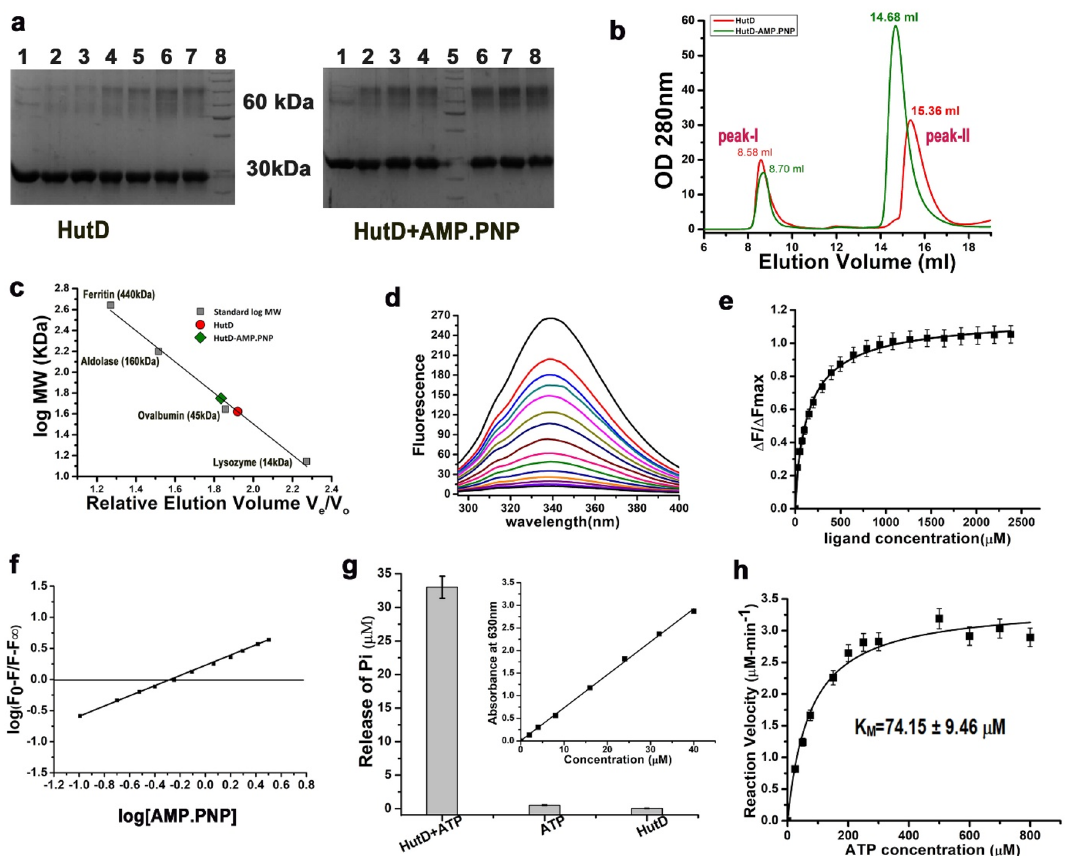
Figure 2. Dimerization and ATP binding/hydrolysis by HutD. ( a ) Crosslinking of HutD with Glutaraldehyde in Nt-free state (left) and after incubation with AMP.PNP showed prevalent dimerization upon incubation with AMP.PNP; left: (L1: Control, L2–L7: after treatment with 0.005–0.04% of Glutaraldehyde, L8: MWM), right: (L1: Control, L2–L4: after treatment with 0.005%, 0.01%, and 0.02% of Glutaraldehyde, L5: MWM, L6–L8: after treatment with 0.03%, 0.035%, and 0.04% of Glutaraldehyde). A cropped version is used here to reduce space and to maintain clarity. Original gel pictures are available in Fig. S1; ( b ) size exclusion chromatography elution profiles of HutD in Nt-free and upon incubation with AMP.PNP; ( c ) the molecular weights of the peaks were determined from the calibration curve prepared using molecular weight standards. Elution volumes suggest strong dimeric shift upon AMP.PNP binding to HutD. ( d,e ) Fluorescence quenching demonstrated significant change in fluorescence upon AMP.PNP binding to HutD; (λ exc = 280 nm, λ em = 295–400 nm) with slit widths of 5 nm for both excitation and emission. Plots of ΔF/ ΔF max against ligand AMP.PNP (mM) obtained a K d value of 94 ± 0.024 μM; ( f ) slope of the straight line indicates 1:1 binding stoichiometry between HutD and AMP.PNP; ( g ) significant ATP hydrolysis of HutD were observed in Malachite green assay and the release of inorganic phosphate ( Pi ) was estimated against the standard curve of KH 2 PO 4 ( Inset ); ( h ) reaction velocity of HutD, measured at a protein concentration of 2.5 μM, were plotted against ATP concentrations (μM) as per Michaelis– Menten equation y = Vmax × x n /(k n + x n ) with ‘One site-specific binding’ model. Error bars in ( e,g,h ) are SD values obtained from at least three